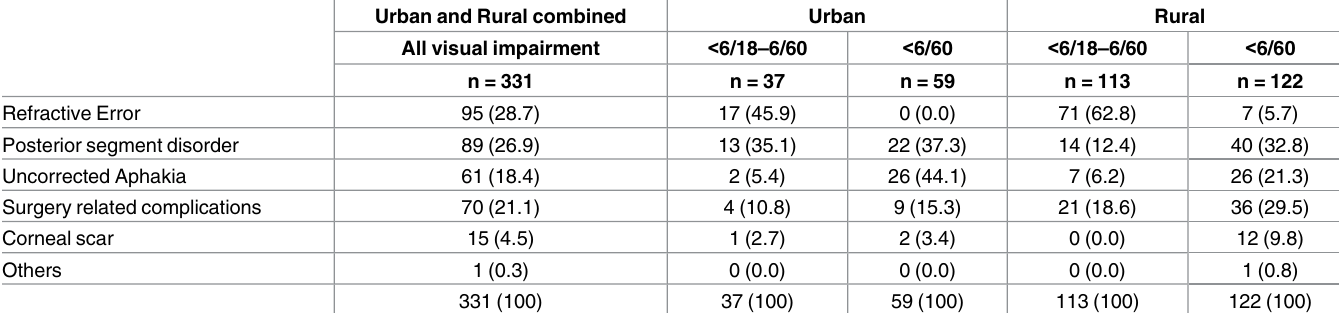
Table 4. Causes of visual impairment in operated eyes.